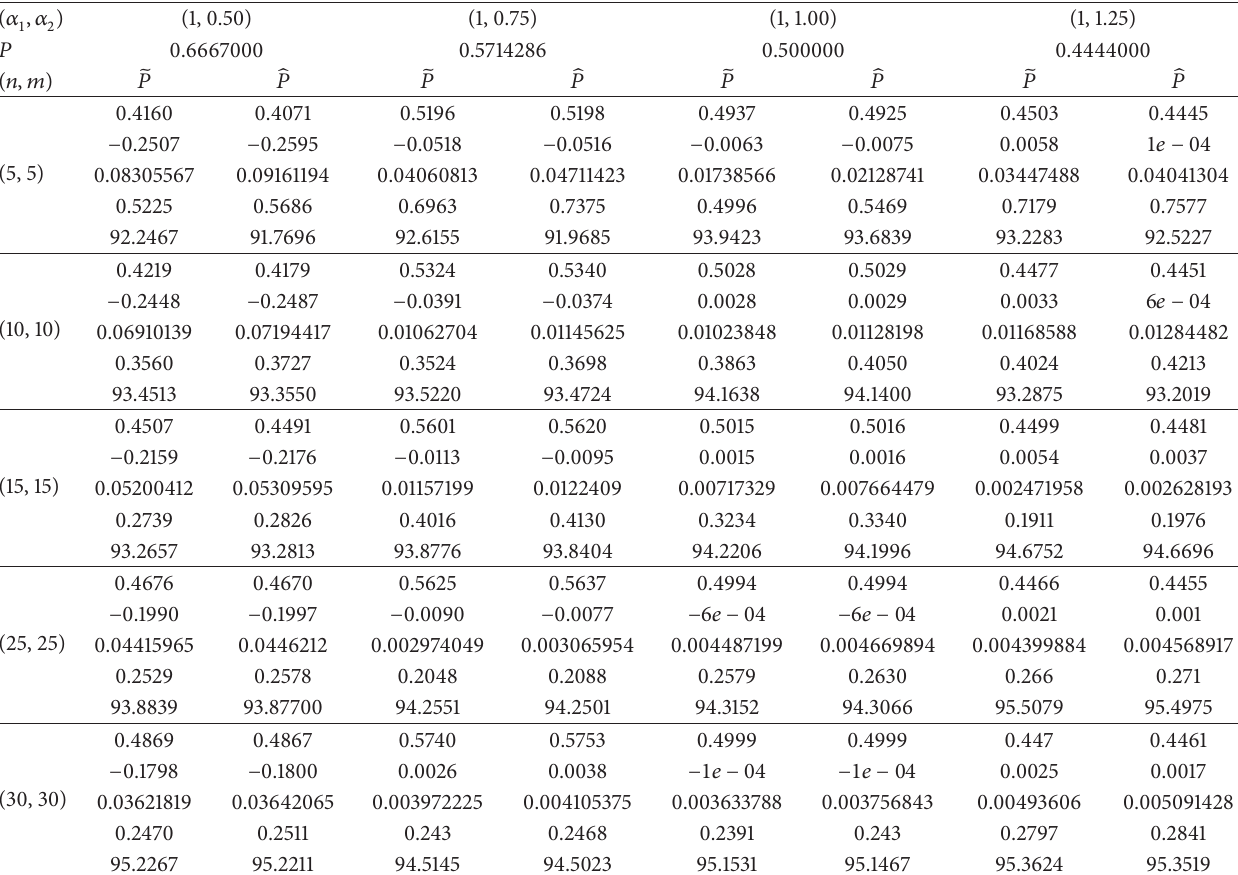
Table 2: Simulation results for “ 𝑃